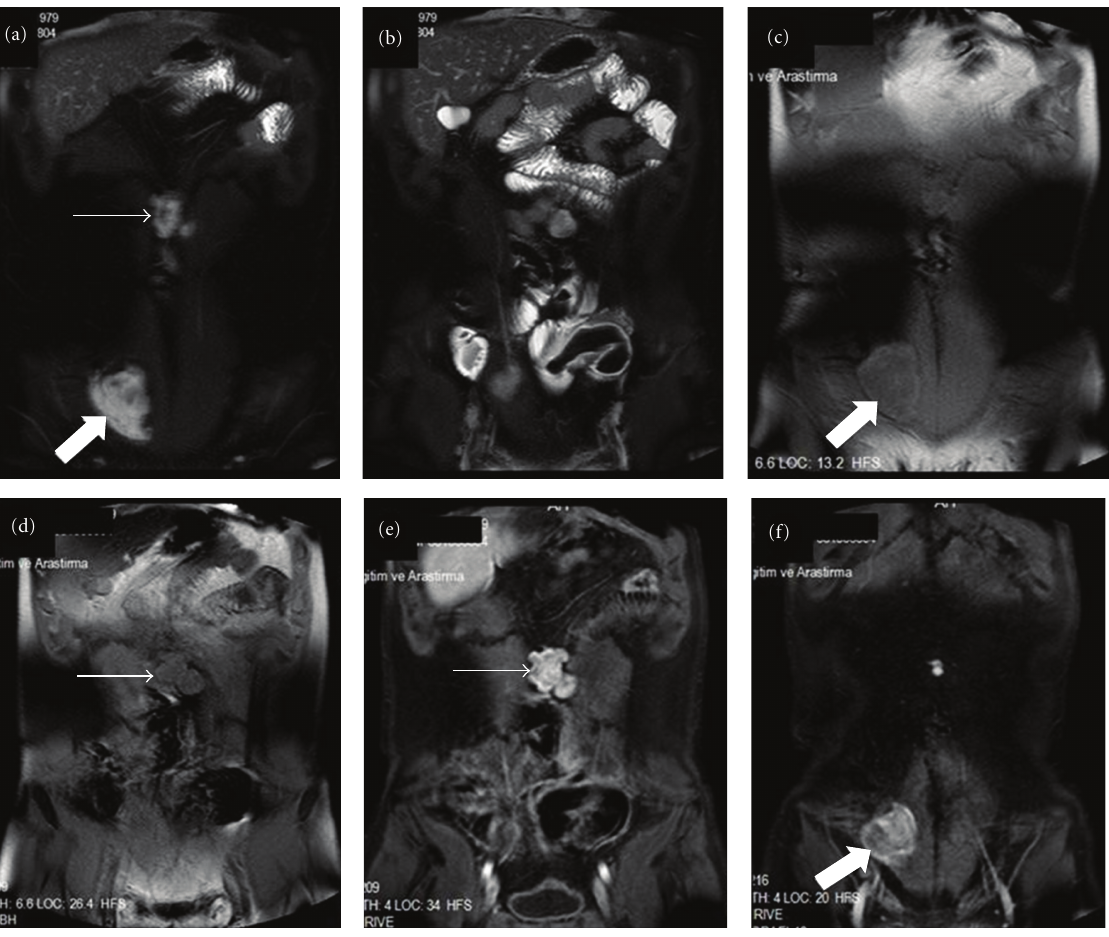
Figure 2: MR enterographic images of the patient 3. On coronal fat-saturated T2- weighted (W) HASTE (a), (b), T1W (c), (d), and contrast- material-enhanced T1W (e), (f), images show the desmoid tumors (thick arrows: inguinal desmoid tumor; thin arrows: mesenteric desmoid tumor). The relationship between contrast-material-enhanced mesenteric desmoid tumor and small-bowel loops is clearly seen on the MR images (arrow,